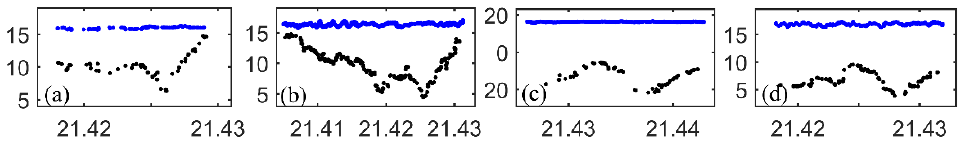
Figure 10. Signal photons on the sea surface (Green) and seafloor (Red) detected from ATL03 for 20190221GT1L and signal photons after refraction correction (Blue) in the St. Thomas area.